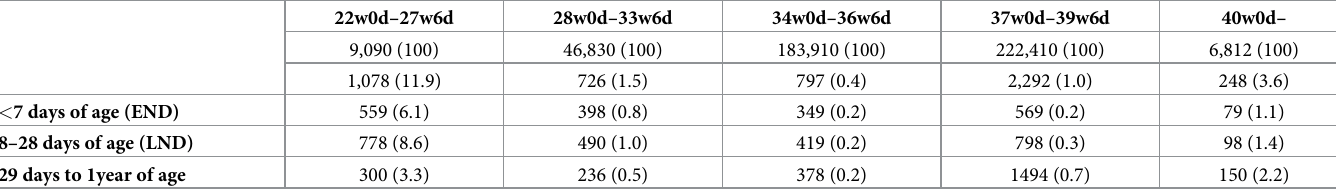
Table 4. Relationship between early neonatal death/neonatal death and gestational